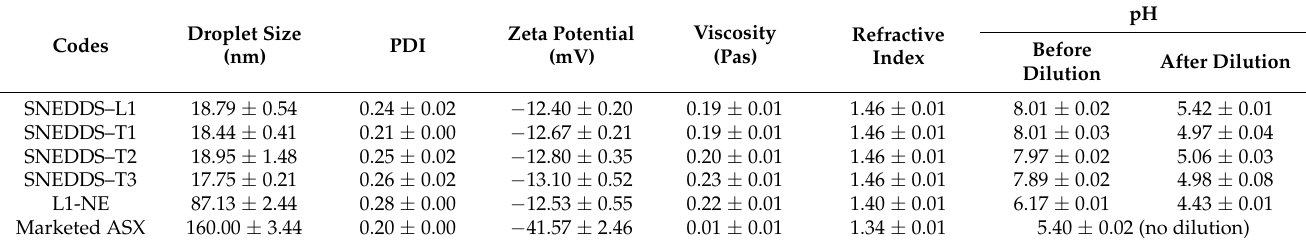
Table 2. Physical characteristics of ASX self-nanoemulsifying formulations (mean ± SD; n = 3).